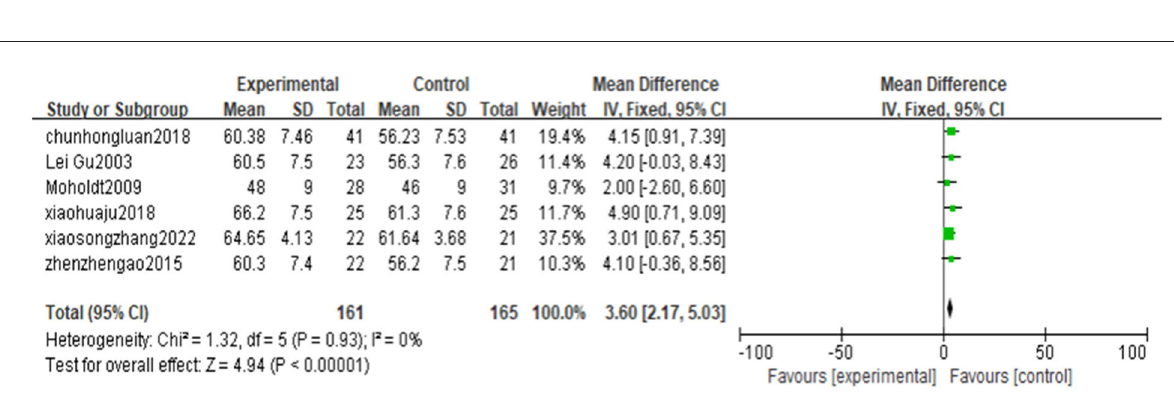
FIGURE5 Forest plot of the effects of high-intensity and moderate-intensity exercise on LVEF in CAD